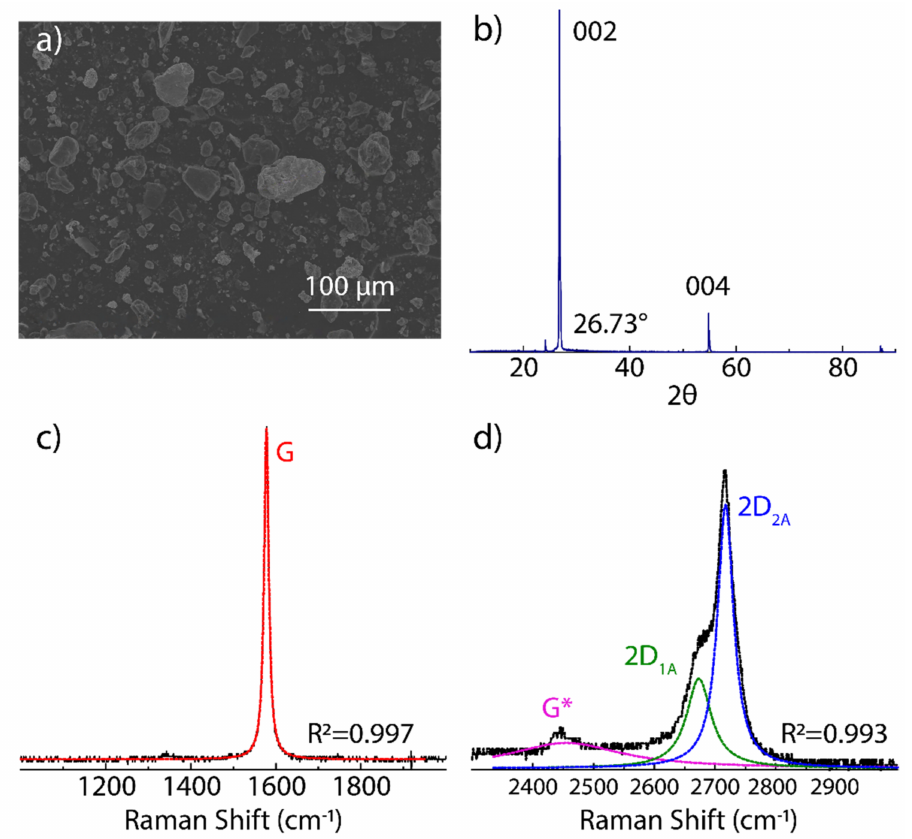
Figure 1. Characterization of starting graphite source: ( a ) SEM morphology, ( b ) XRD measurement, and ( c , d ) Raman spectrum from 1000 to 3000 cm − 1 recorded using 532 excitation laser. The intensity was normalized by the most intense peak. The Raman spectrum was fitted using Lorentzian